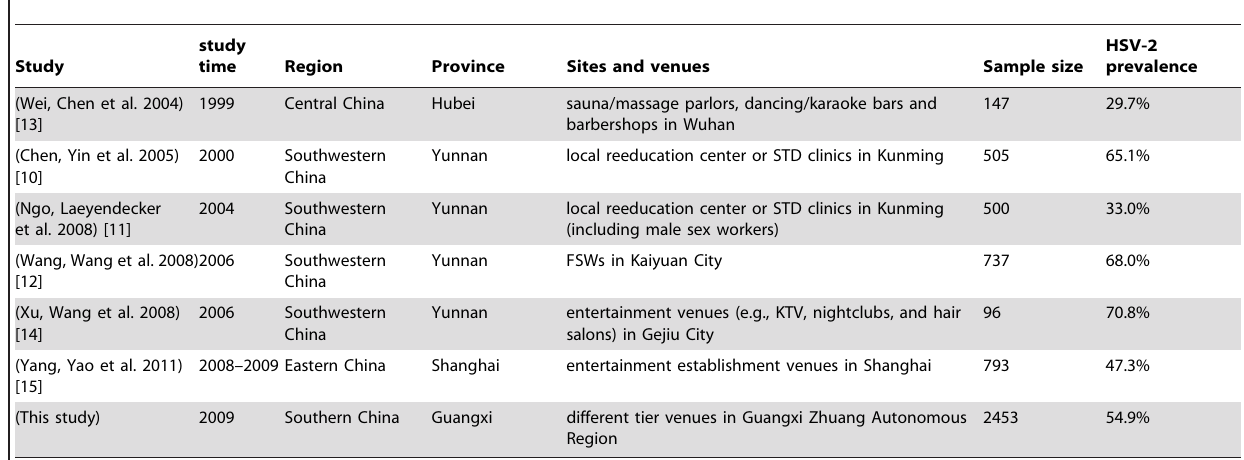
Table 2. Comparison among different studies on HSV-2 seropositivity in FSWs in China.